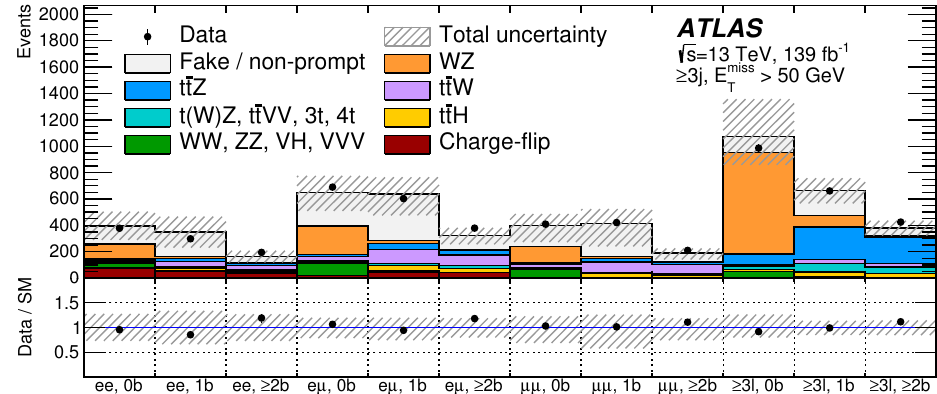
Figure 2. Data event yields compared with the expected contributions from relevant SM processes (section 5) and the reducible background (section 6), after a loose preselection requiring events with same-sign leptons, E miss > 50 GeV and at least three jets with p T > 40 GeV. The observed and T predicted event yields are classi(cid:12)ed as a function of the number and (cid:13)avour of the leptons, as well as the number of b -tagged jets. The uncertainties, shown with hashed bands, include the total uncertainties in the reducible background, as well as the modelling and statistical uncertainties for the Monte Carlo simulations.